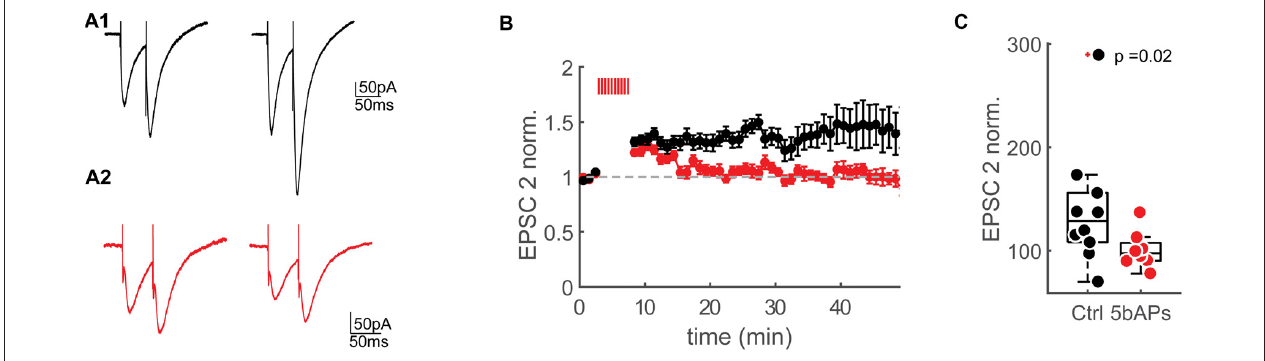
FIGURE 5 | Reduction of NMDAR-currents by AP firing. (A1) Extracellular synaptic paired-pluse stimulation evoked EPSCs under control conditions at baseline (0–2 min) and 30–35 min after the control window (stimulation artifacts were clipped). (A2) Extracellular synaptic paired-pulse stimulation evoked EPSCs at baseline (0–2 min) and 30–35 min after bursts of 5bAPs (stimulation artifacts were clipped). (B) Time plots of normalized, binned (1 min) maximum amplitudes of the second EPSC (EPSC2) under control conditions (black) and after applying 10 bursts of 5bAPs (indicated with red lines, red, plotted as mean ± SEM). (C) Median box plot of the normalized EPSC2 amplitudes of the control experiments and after 10 bursts of 5bAPs) time point: 30–35 min after induction or control window). Statistics: Wilcoxon-Mann-Whitney Test.